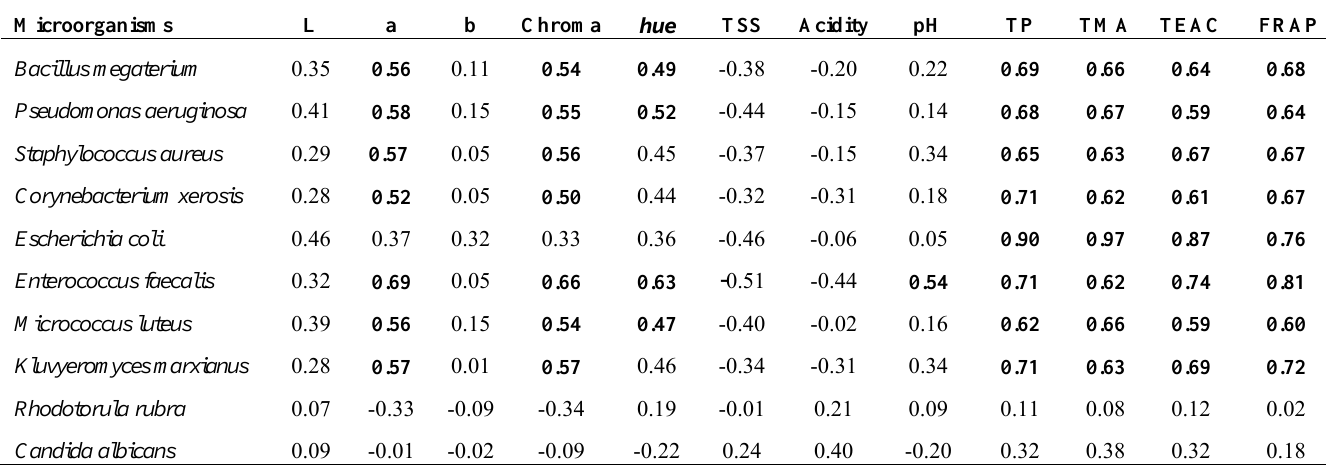
Table 4 . Correlation coefficients of inhibition zones on several microorganism caused by six pomegranate cultivars and their fruit characteristics. Significant correlations are bolded at p ≤